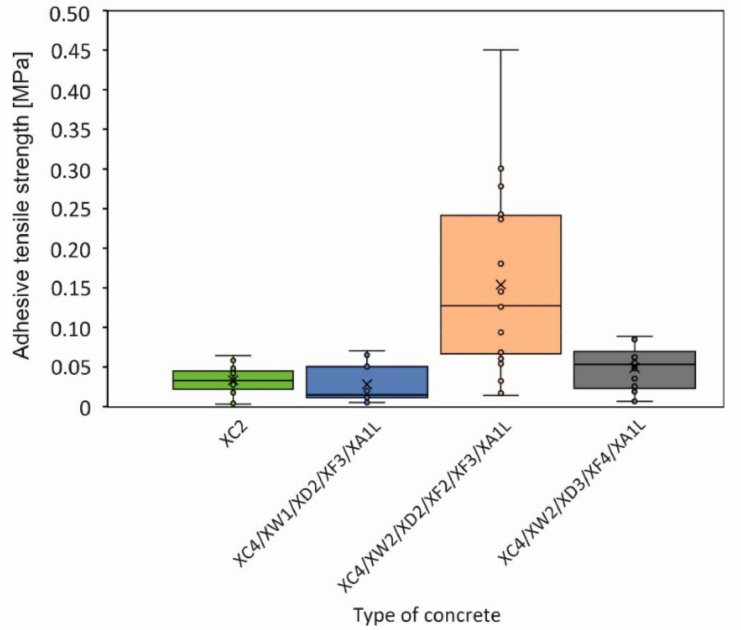
Figure 12. Boxplot of the adhesive tensile strengths between stone and concrete mortar for different concrete recipes.